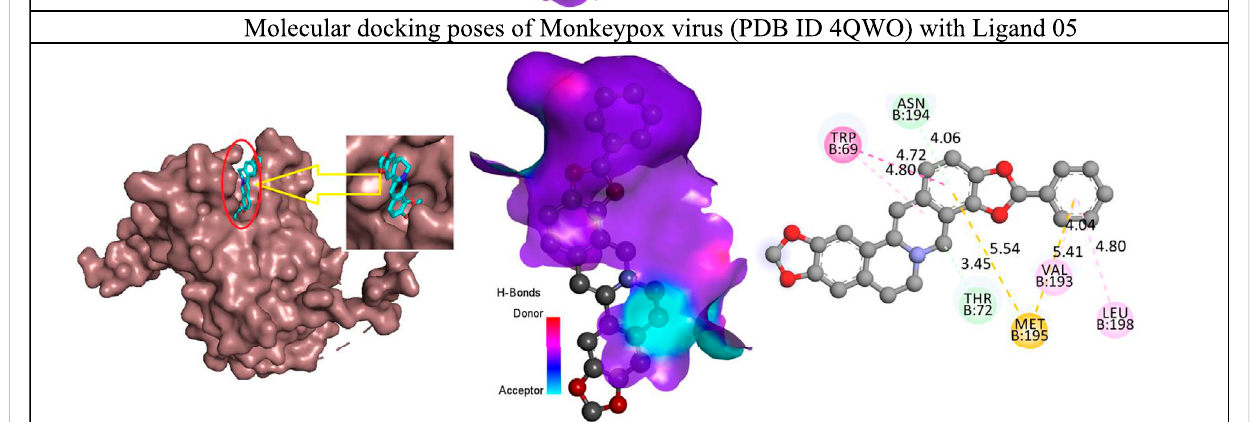
FIGURE 4 Docking interactions between the proposed compound and targeted